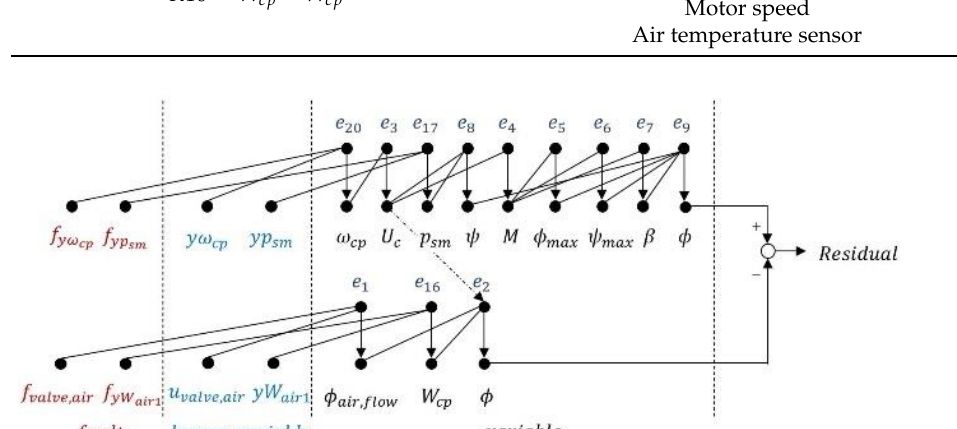
Figure 6. Bi-partite graph of equation set with analytical redundancy.